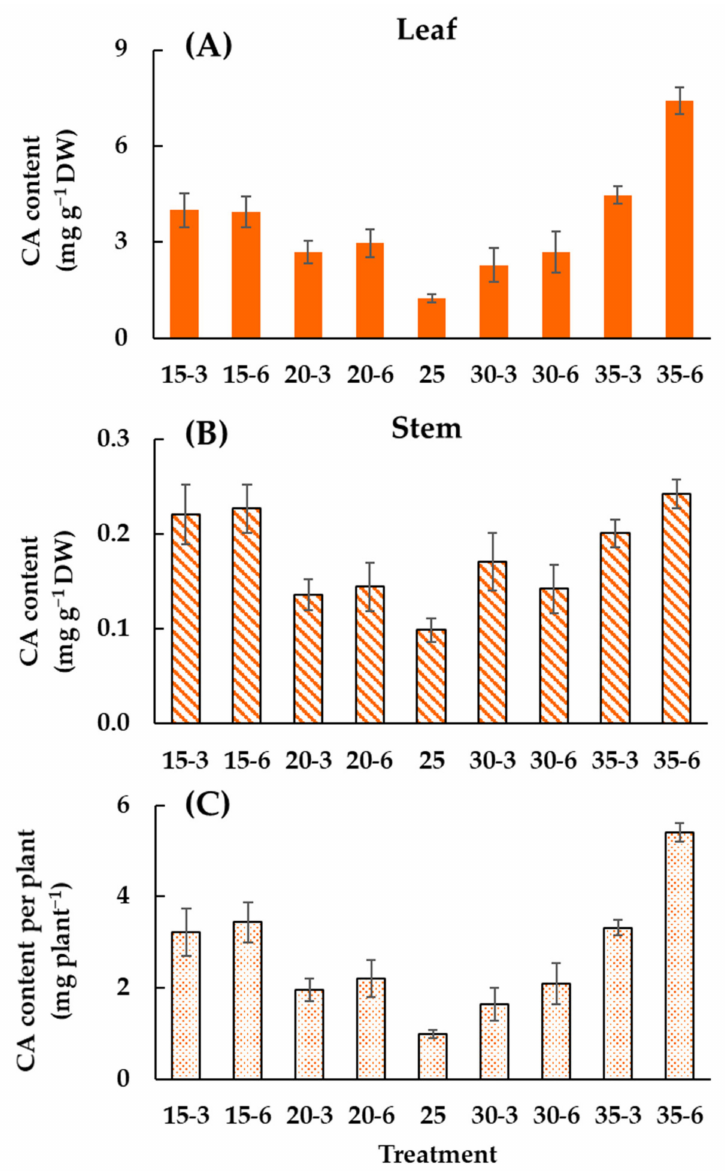
Figure 6. Chlorogenic acid (CA) content per unit of leaf dry weight (DW) ( A ), CA content per unit of stem DW ( B ), and CA content per plant ( C ) in coriander plants after 18 days of cultivation under di ff erent root-zone temperatures and stress periods. Data are shown as the mean ± SE, n =